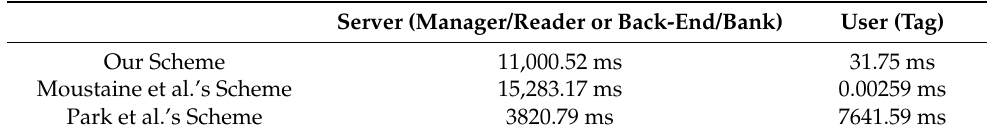
Table 3. The cost comparison of the single-user situation between [3,4] and our scheme.